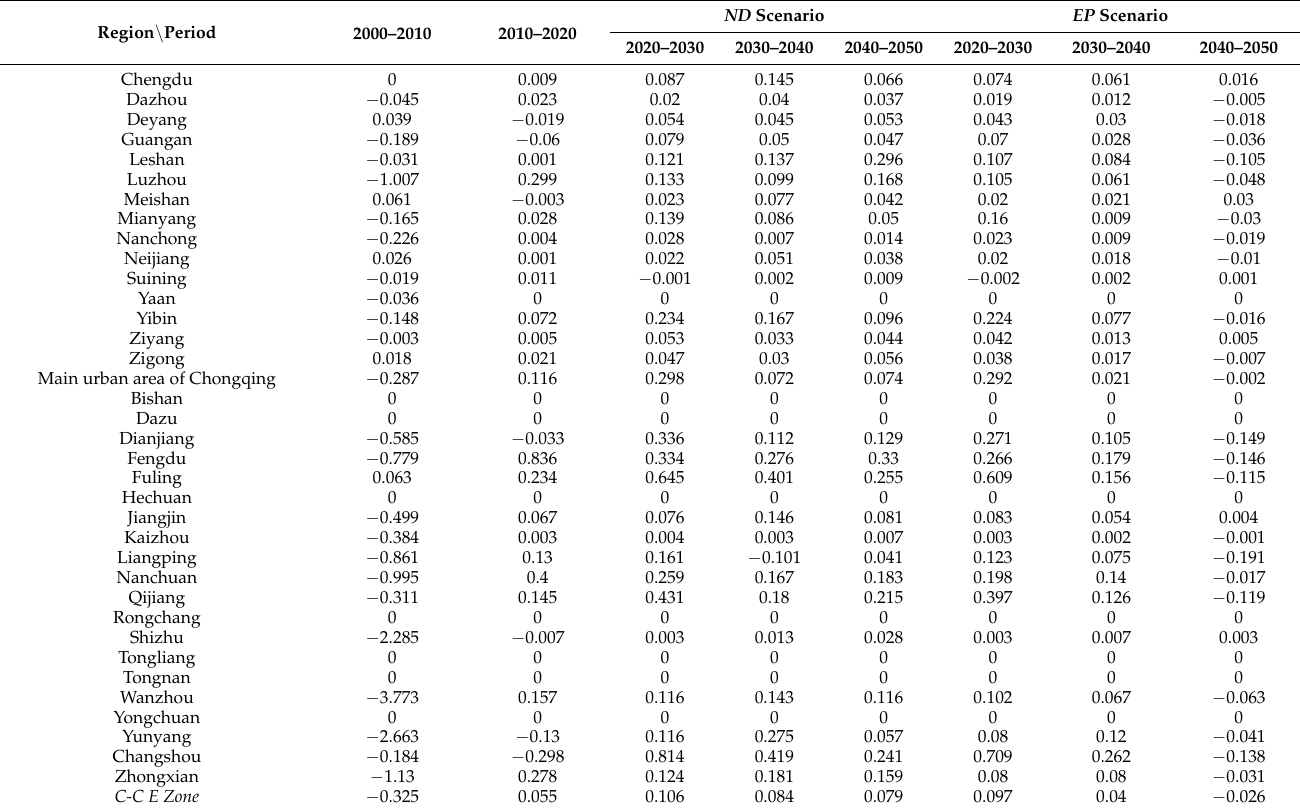
Table 4. Rate of change in the high and extremely high risks of LER in each region. Region \